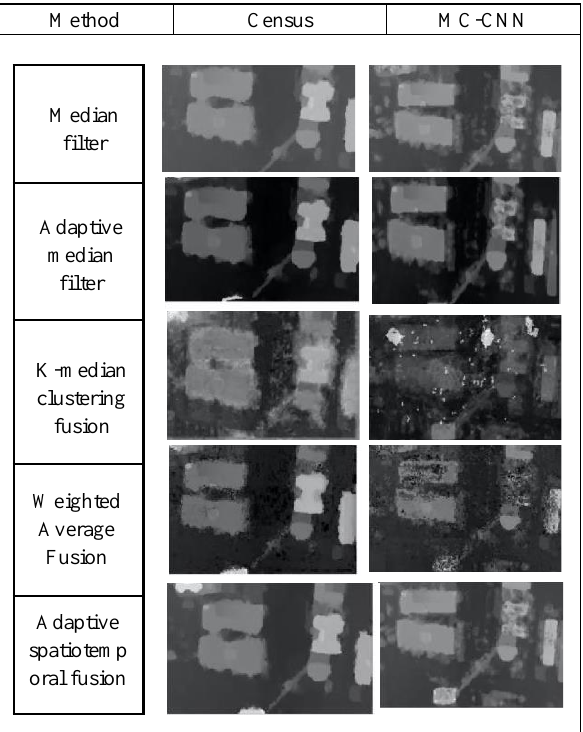
Figure 4. sample subsection of JAX II dataset to show the difference between Census and MC-CNN in the fusion Table 2. The uncertainty of the fused DSMs. Note: The abbreviations stand for median filter (MF), Adaptive median filter (AMF), adaptive spatiotemporal fusion (ASPF), K-median clustering fusion (KMF), and weighted average fusion (WAF), and Bold numbers indicate the lowest RMSE for all fusion methods in each testing region and each DSM generation algorithm.